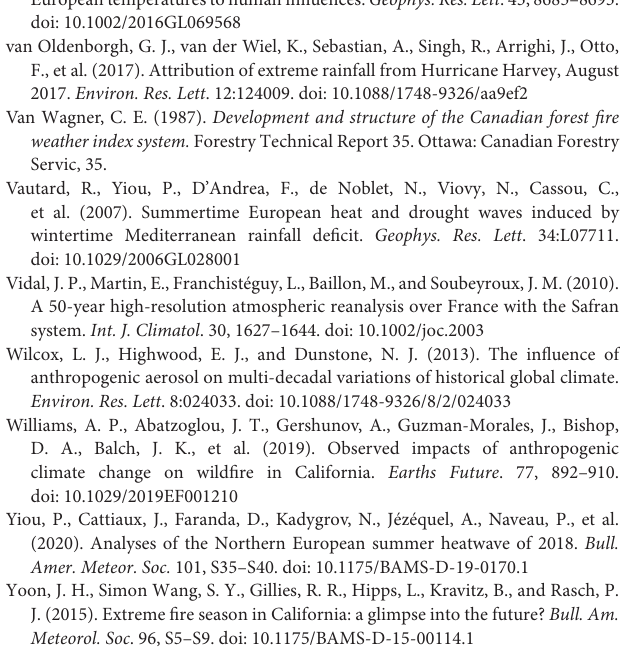
table depth. Agric. Forest Meteorol . 203, 1–10. doi: 10.1016/j.agrformet.2014.